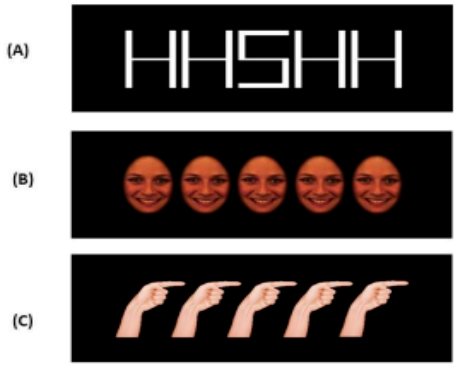
Figure 1. Stimulus examples . ( A ) The stimulus example in the incongruent condition in L-FT; ( B ) the congruent condition in F-FT (happy target–happy flankers); ( C ) the congruent condition in